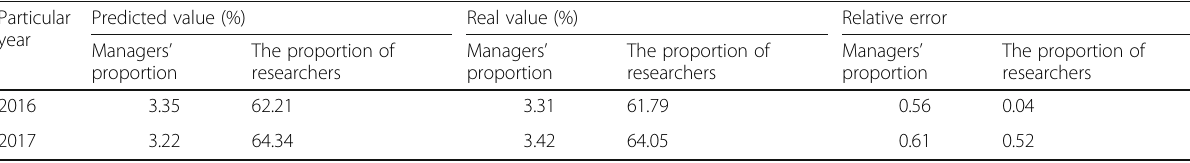
Table 1 Comparison between predicted and actual values Particular